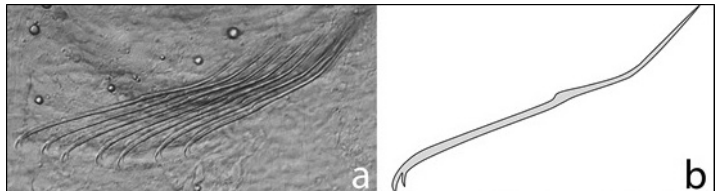
Figure 3. Chaetogaster : A photograph of typical bifid ventral chaetal bundle B drawing showing shape of one